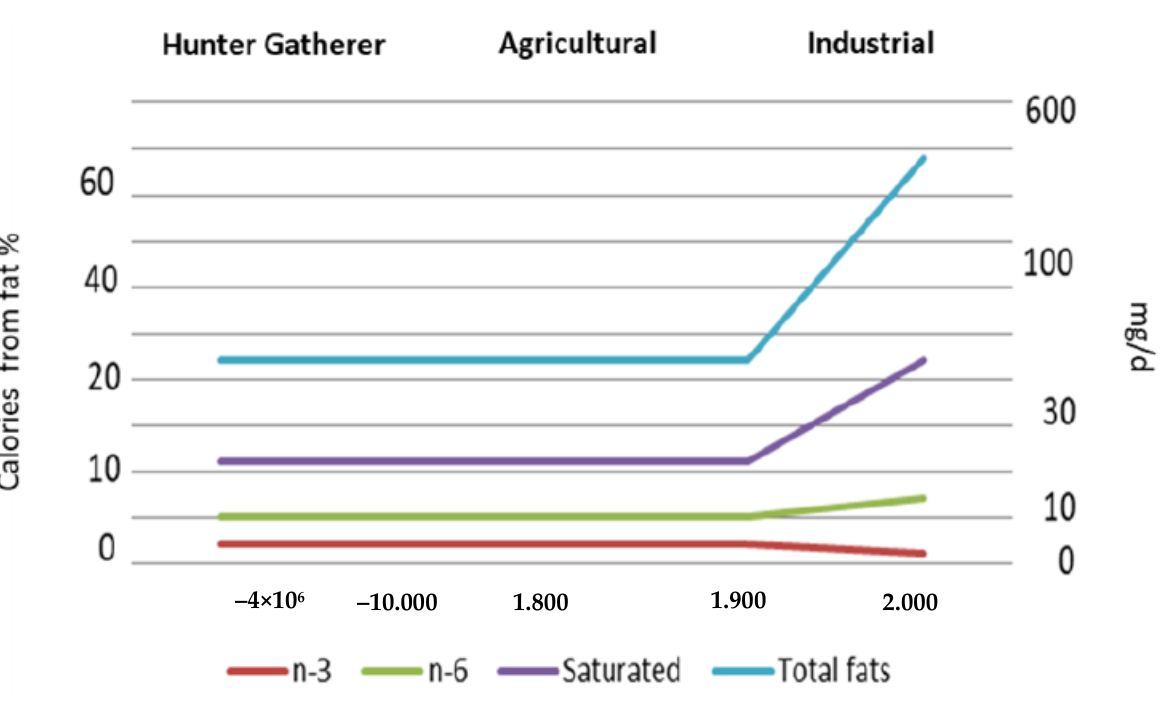
Figure 1. Estimated intake (mg/d) of n-3, n-6, saturated fatty acids, and total fats in relation to calories (%) provided by fat during human evolution. Data from Simopoulos, 2019